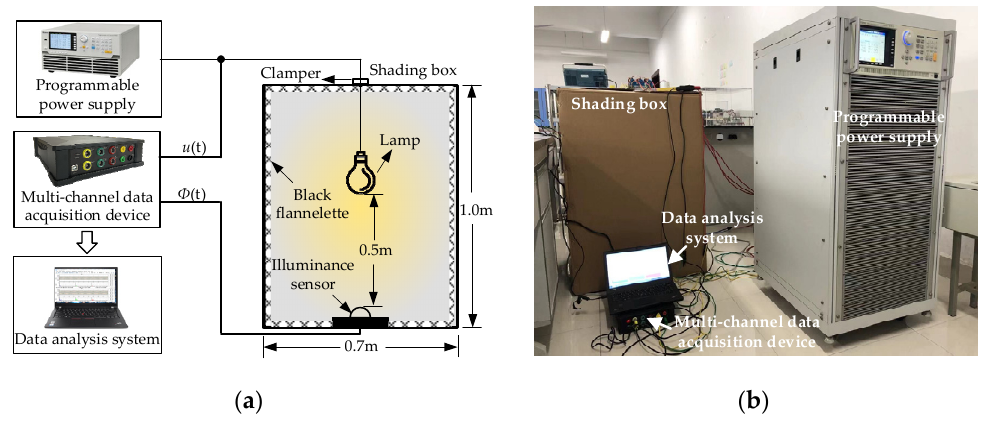
Figure 2. Interharmonics-luminous flux test system: ( a ) schematic and ( b ) actual layout. During the test, a clamp was used to fix the lamp to be tested in the middle of the shading box and the illuminance sensor was placed horizontally directly below the